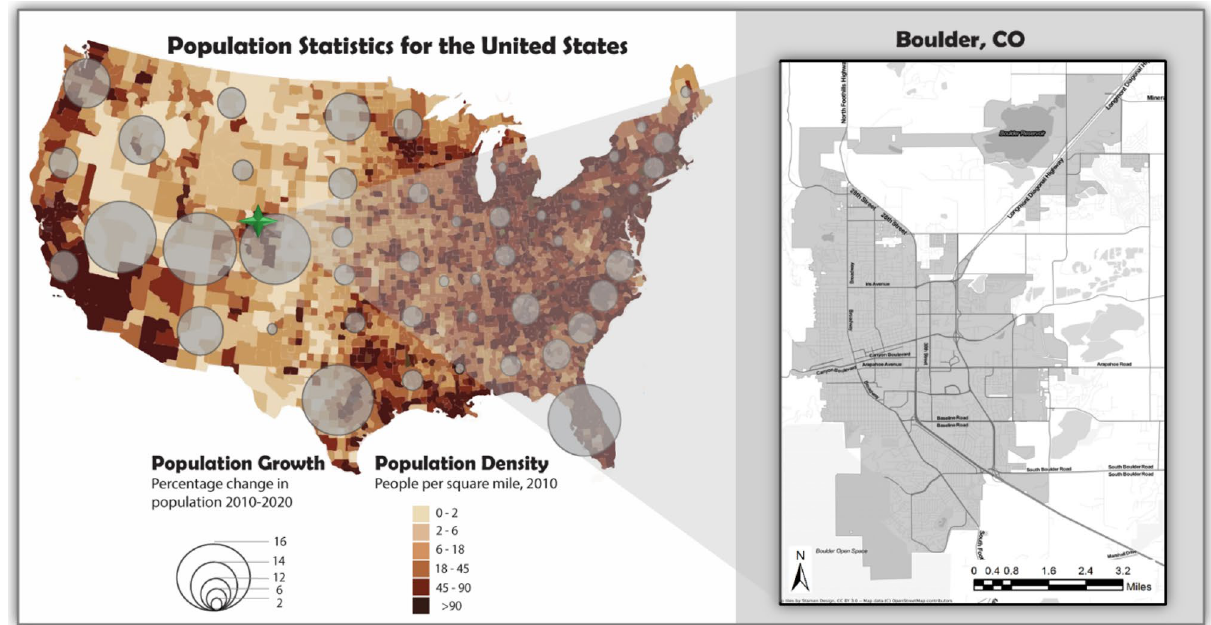
Figure 2. Population statistics in the United States and Boulder, the testbed of this study—figures created using Python 3.9.5 (https:// www. python. org/ doc/).